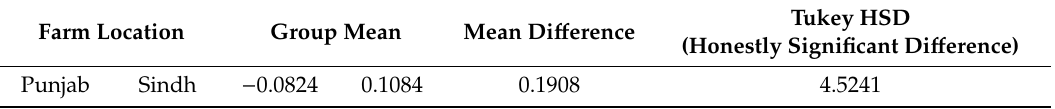
Table 8. Posthoc pairwise comparisons in the overall assessment of